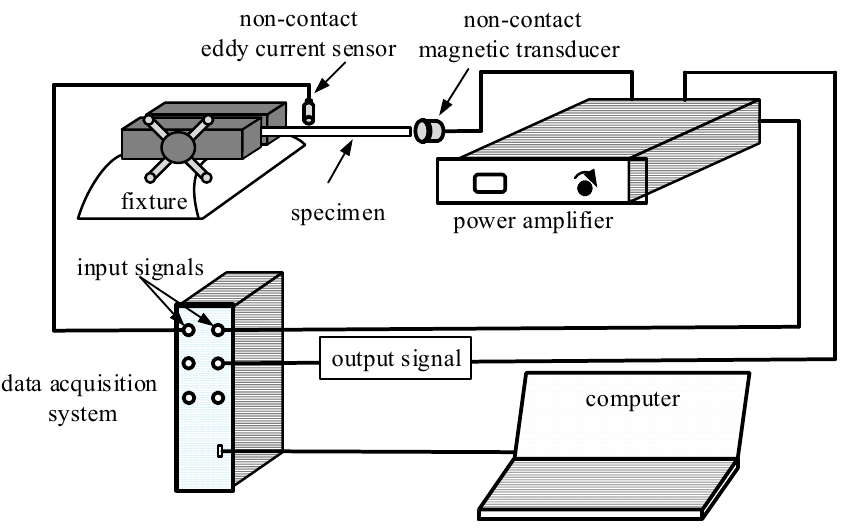
Figure 5. Schematic diagram of the experimental apparatus.